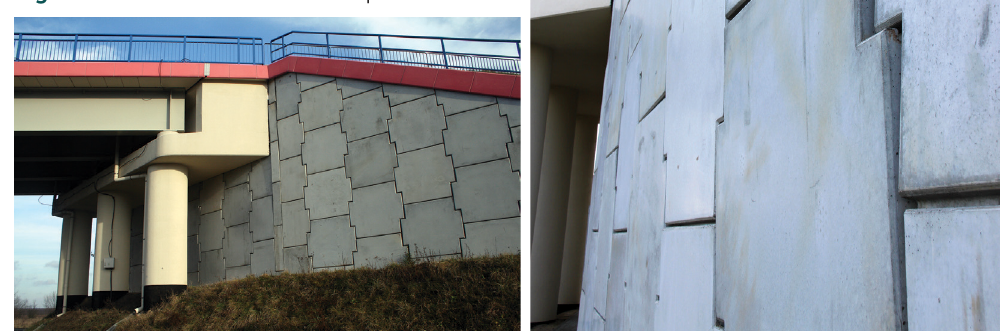
Figure 1. General view of the